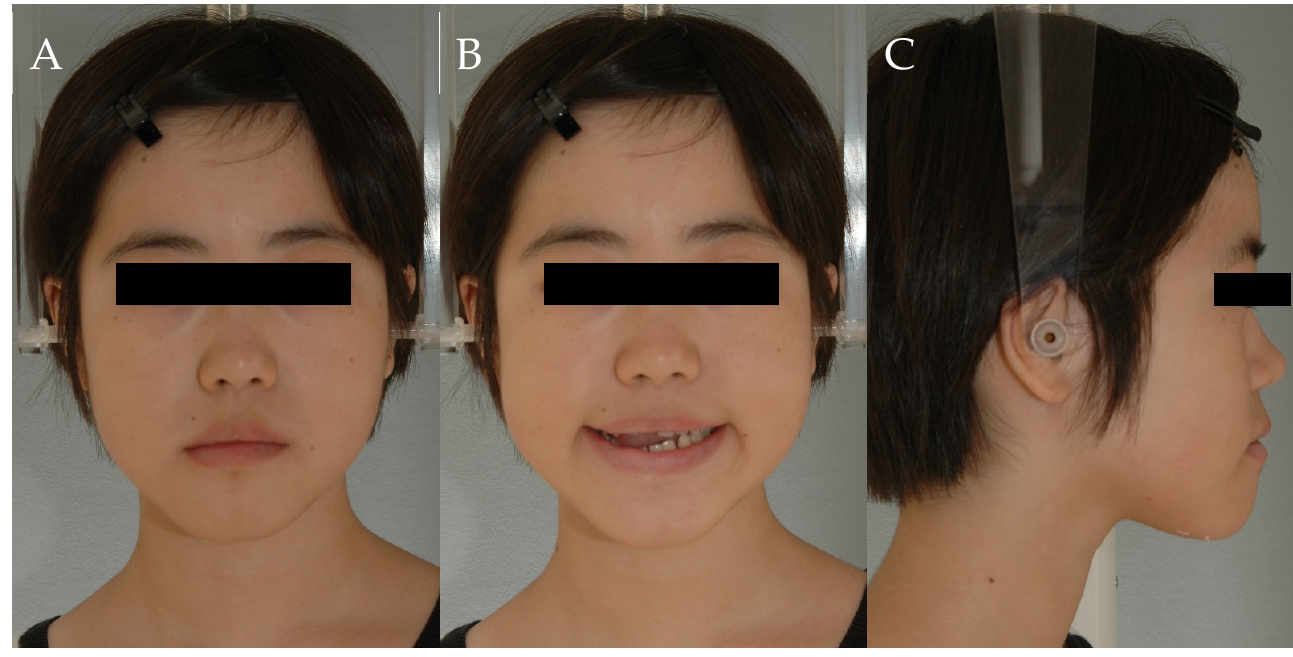
Figure 1. Pre-treatment facial photographs. ( A ) Front view; ( B ) smile view; ( C ) lateral view.